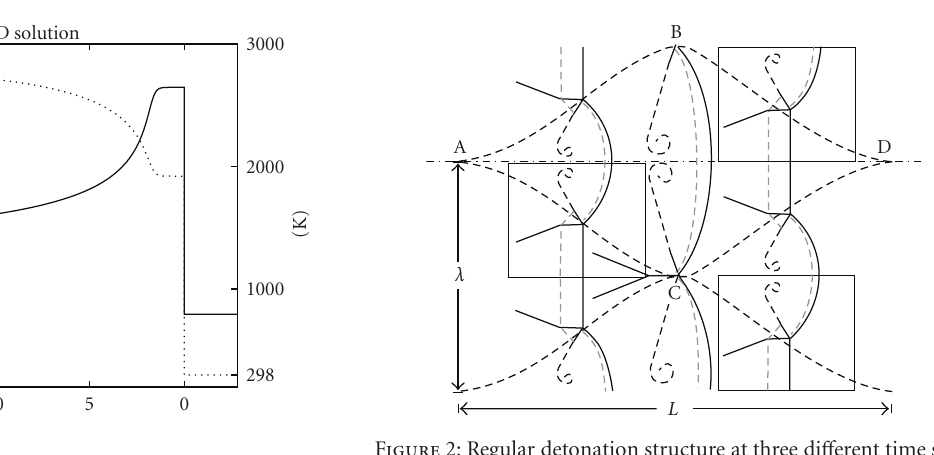
Figure 2: Regular detonation structure at three di ff erent time steps drawn on top of the triple point